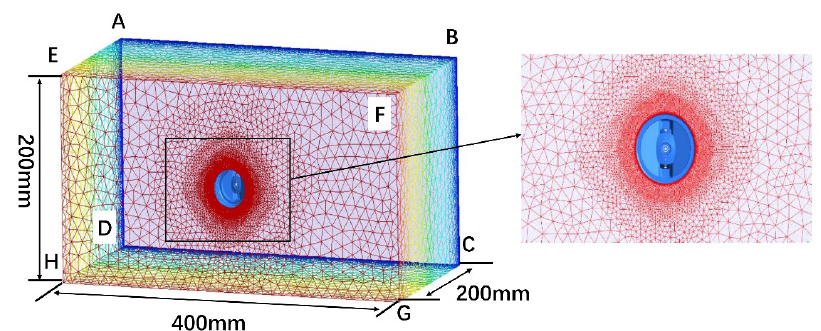
Figure 2. Mesh of the computational domain.